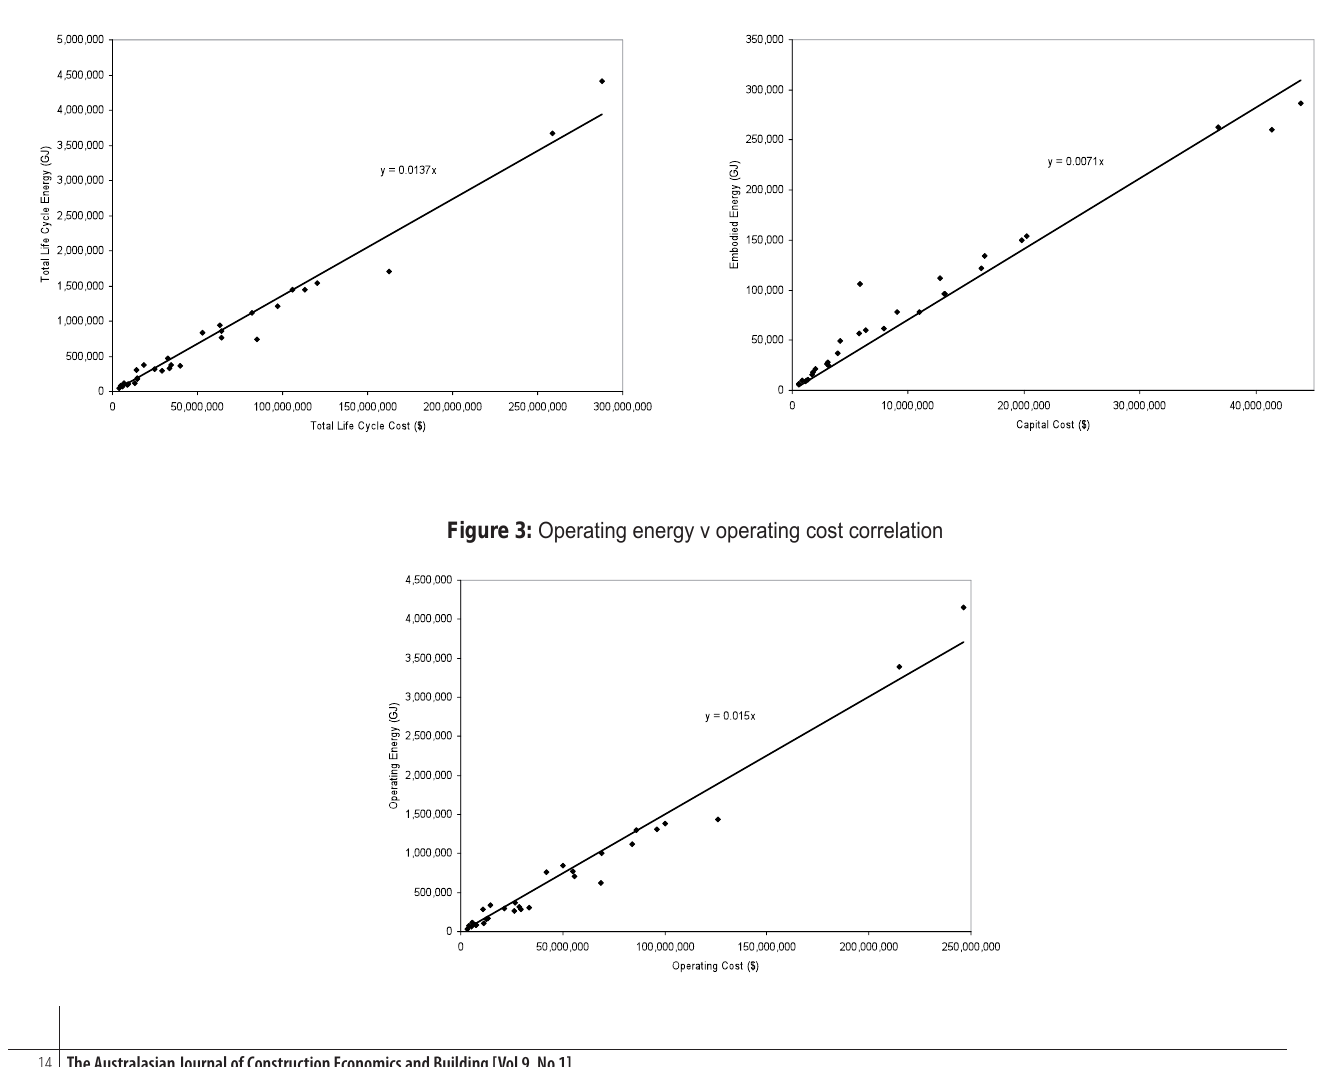
Figure 1: Total project energy v cost correlation Figure 2: Embodied energy v capital cost correlation